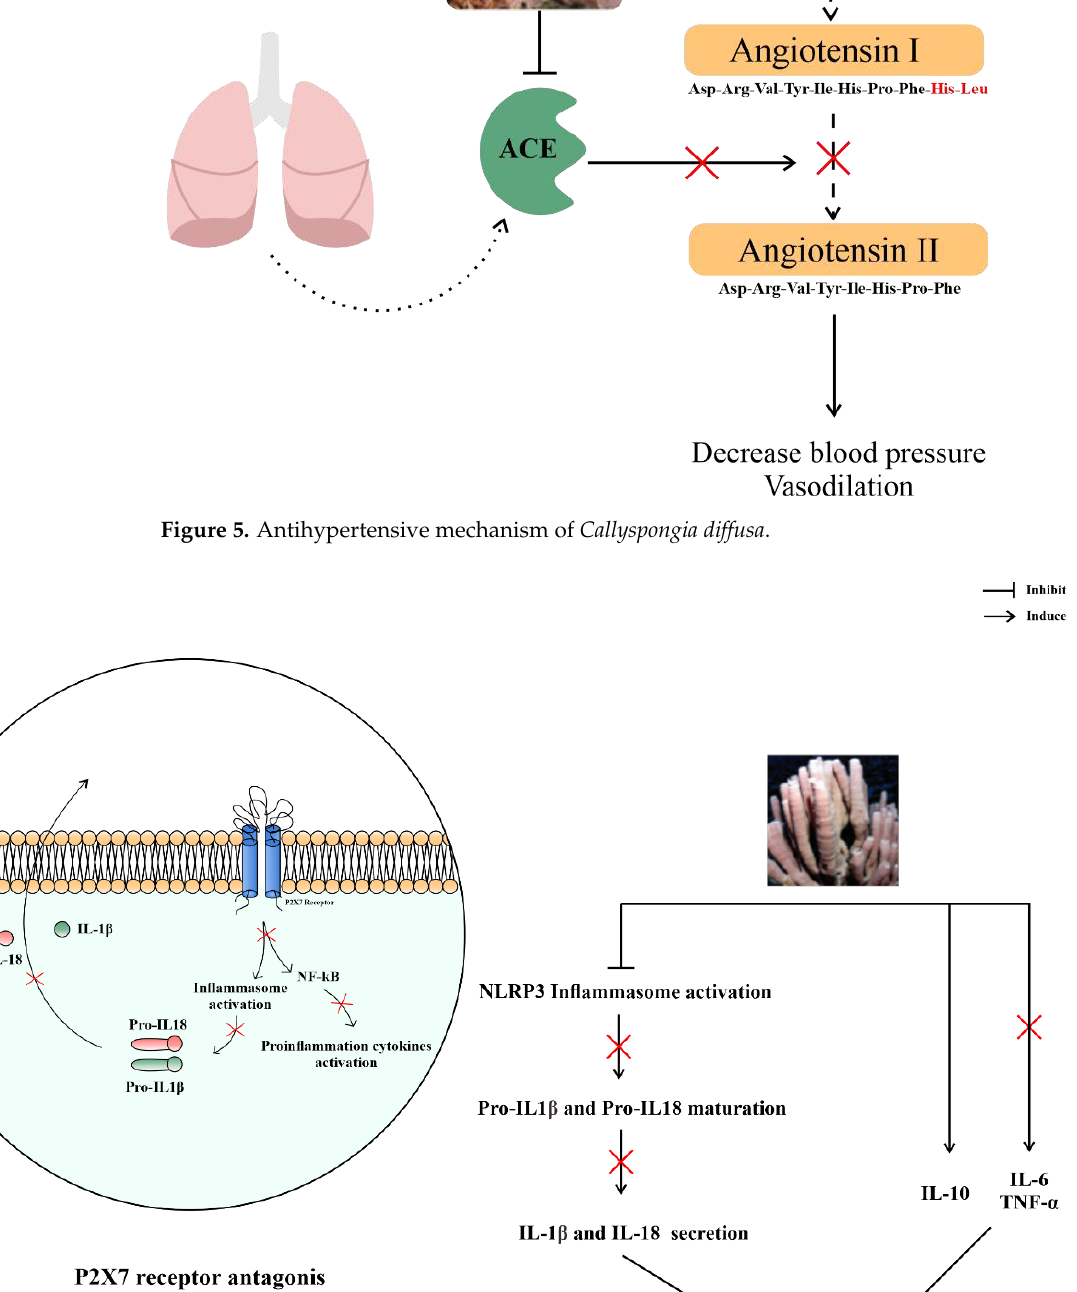
Figure 6. Prediction of anti-inflammatory mechanisms of compounds from the subgenus Callyspon- gia .